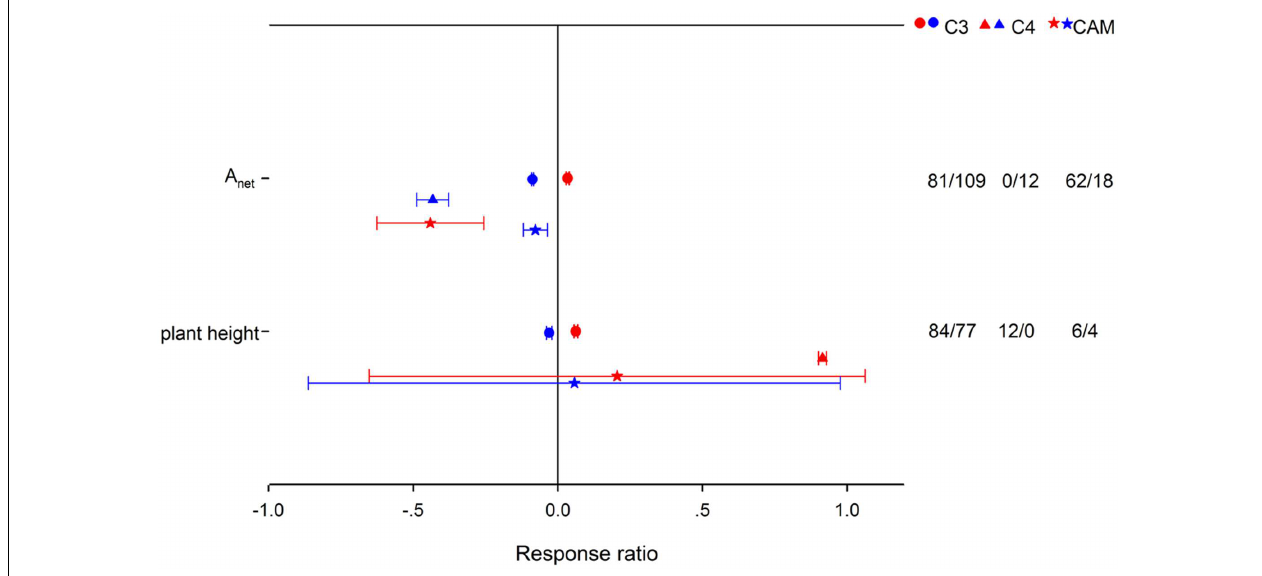
FIGURE 2 | Photosynthetic rate ( A net ) and plant height responses to HNT (red) and LNT (blue) in C 3 (circles), C 4 (triangles), and CAM (stars) species. Each data point represents the mean ± 95% CI. The number of observations for each variable is given on the right of the graph.